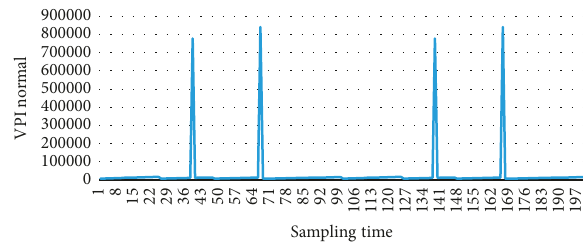
Figure 18: Feature of ADTI for normal traffics.